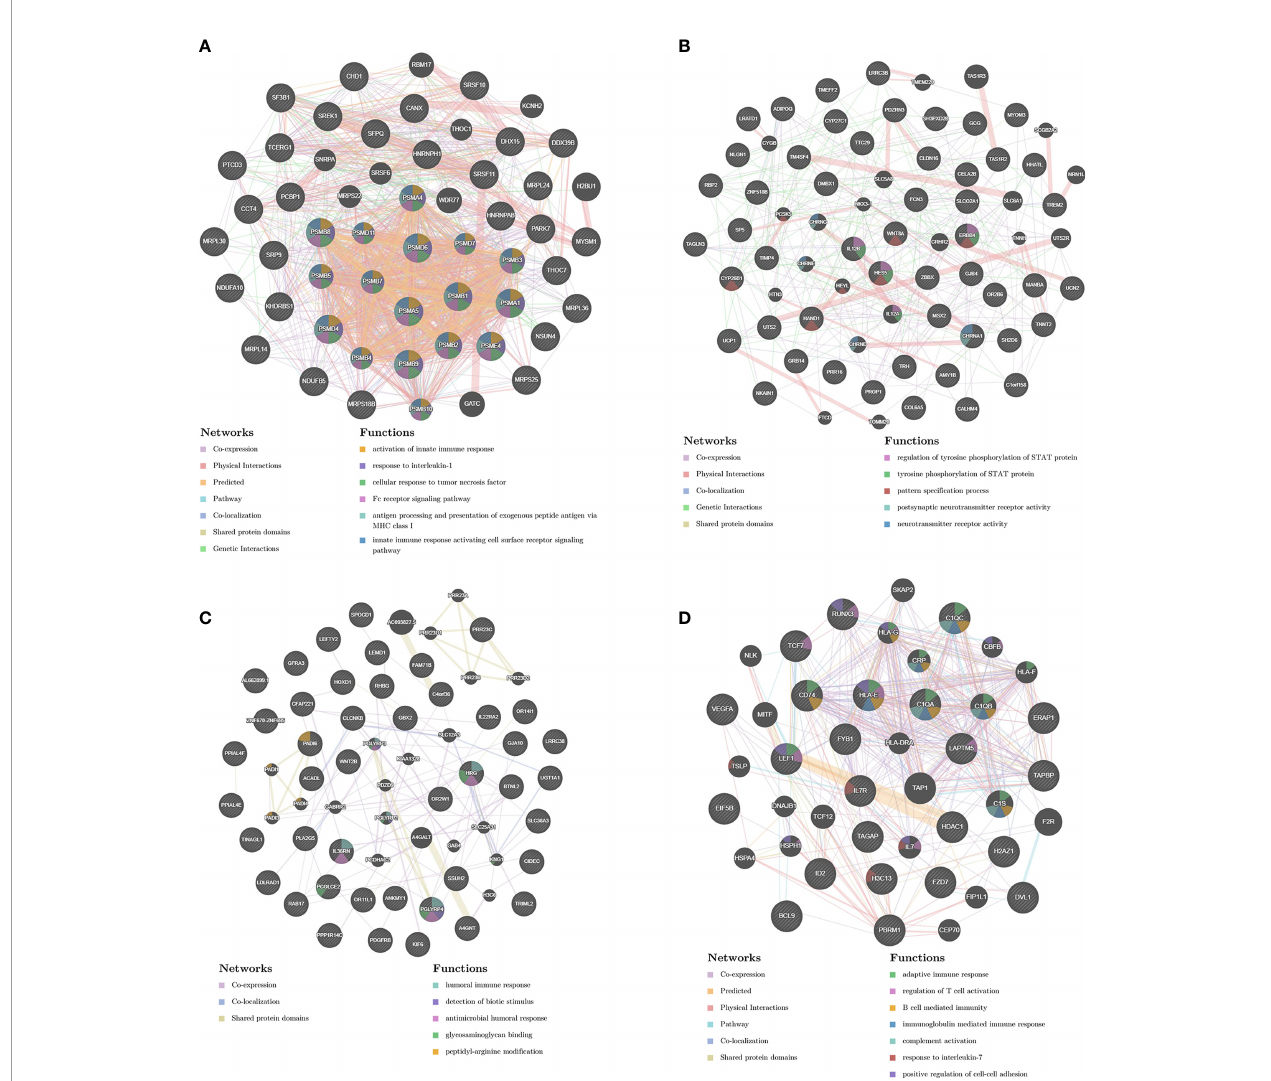
FIGURE 7 | PPI network construction. The PPI network of brown (A) , darkorange (B) , yellow (C) and steelblue (D) module. Different colors in each node represent different functions as indicated. Function of genes in dark node was not revealed through the analysis. Different colors in each edge represent different